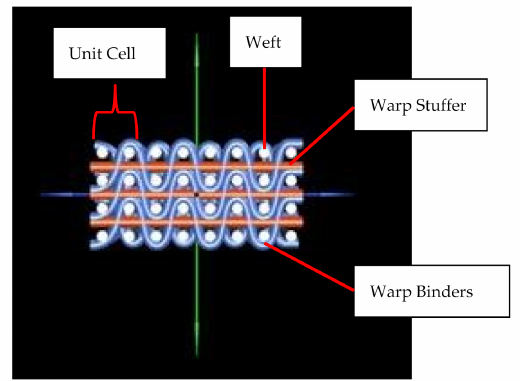
Figure 1. Layer-to-layer weave architecture.